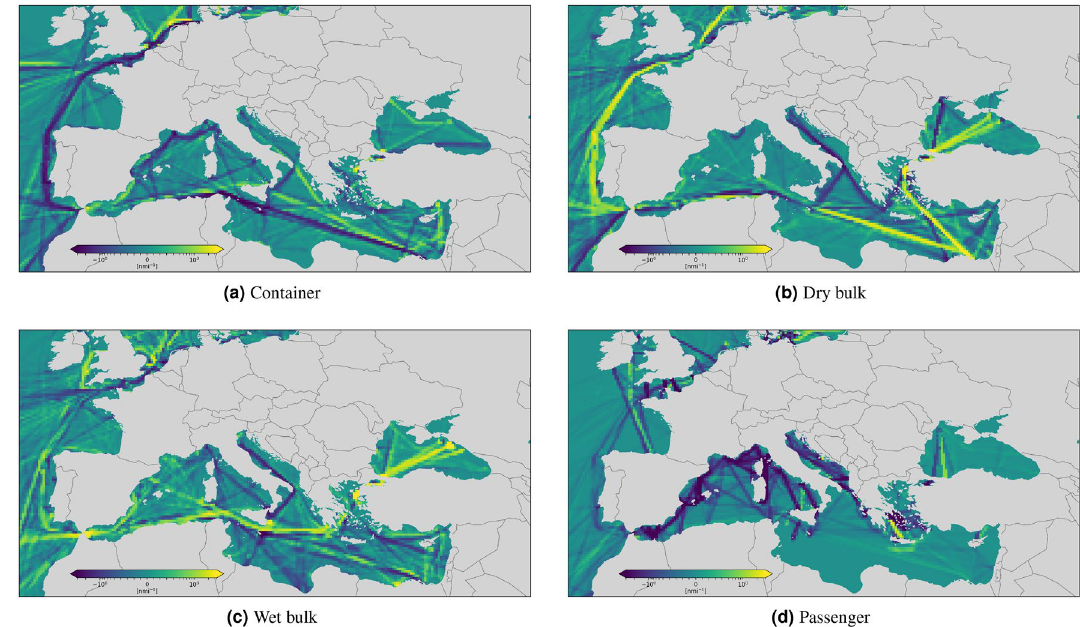
Figure 9. Monthly CNM density difference in the Mediterranean Sea between 2020 and 2019 for container ( a ), dry ( b ), wet bulk ( c ) and passenger ( d ) shipping. The considered time period is from 13 March to 13 April. Each grid cell is colored based on the variation of the 2020 value with respect to 2019, ranging from dark purple, which represents a decrease of CNM in 2020 with respect to 2019, to bright yellow, which represents an increase of navigated miles in 2020 with respect to the previous